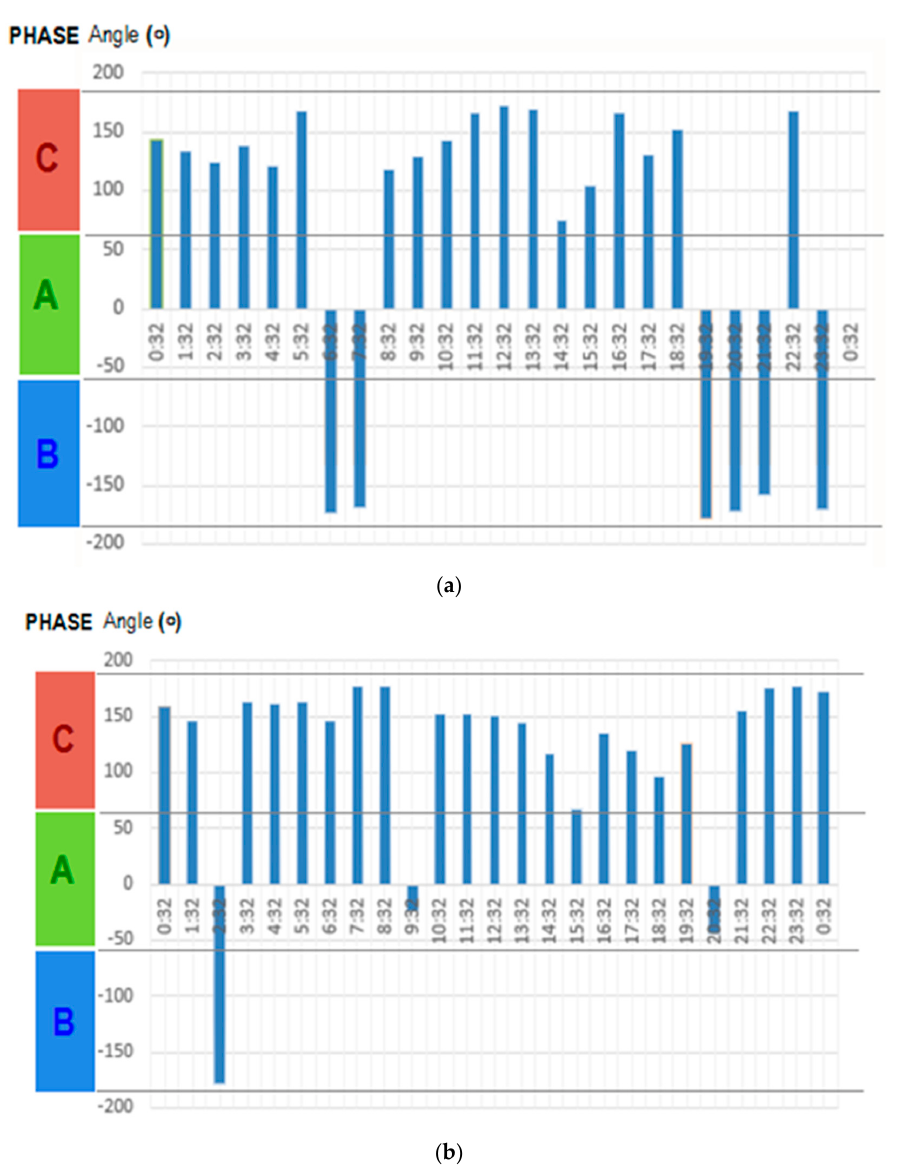
Figure 2. Imbalances throughout a day in the distribution transformer of an industrial area, due to ( a ) active loads ( α p ), and ( b ) reactive loads ( α q